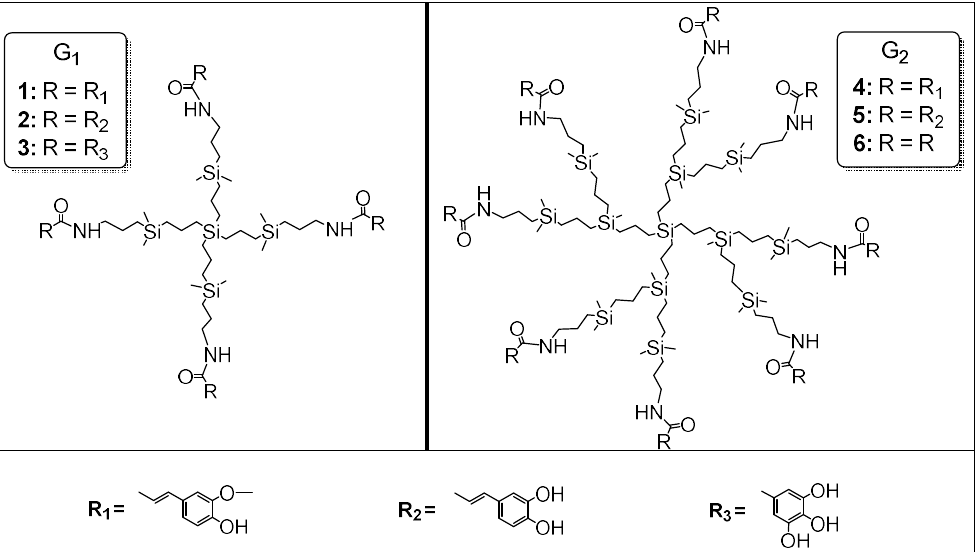
Figure 1. Proposed structures for polyphenolic carbosilane dendrimers ( 1 ‒ 6 ).